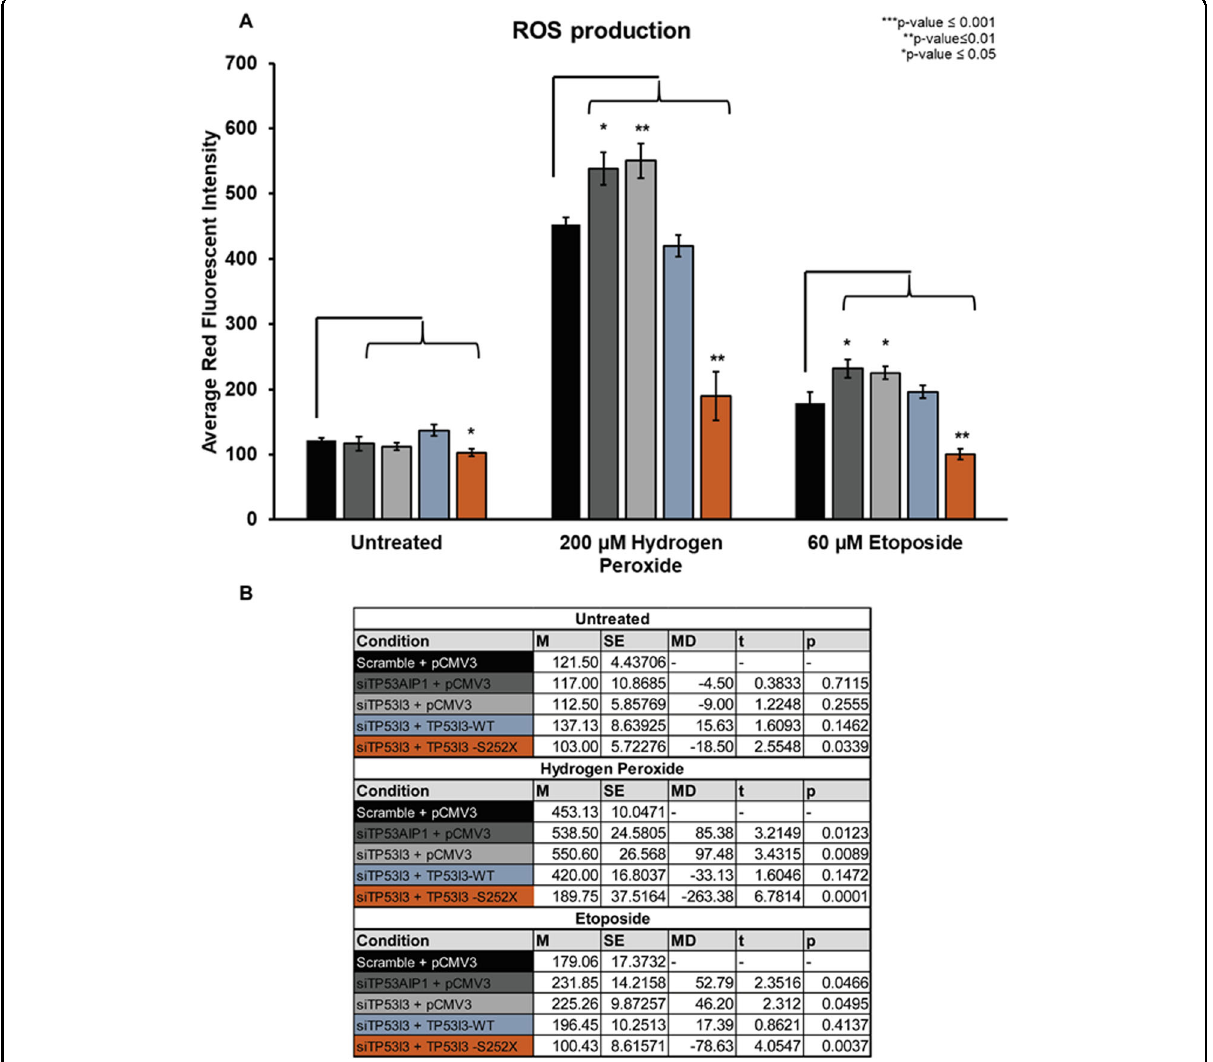
Fig. 7 Effect of TP53I3-S252X to mitochondrial ROS production. Red fl uorescent intensity ( y axis) was measured for knockdown of TP53AIP1 or TP53I3 in HeLa cells (without DR-GFP). The population of TP53I3 knockdown cells was rescued with TP53I3-WT or TP53I3-S252X mutant. All conditioned cells were then by treatment with H 2 O 2 or etoposide. B The signi fi cance test was based on comparing the positive control, Scramble and SCE1, to knockdown and/or rescue conditions. With an n = 5, p values ≤ 0.05 were considered statistically signi fi